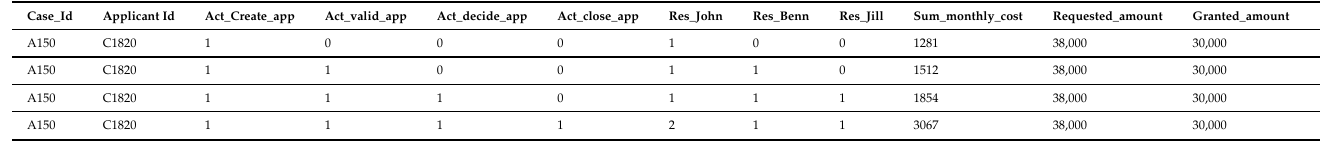
Feature vector created for case with id = A150 from the log in Table 1 using aggregated